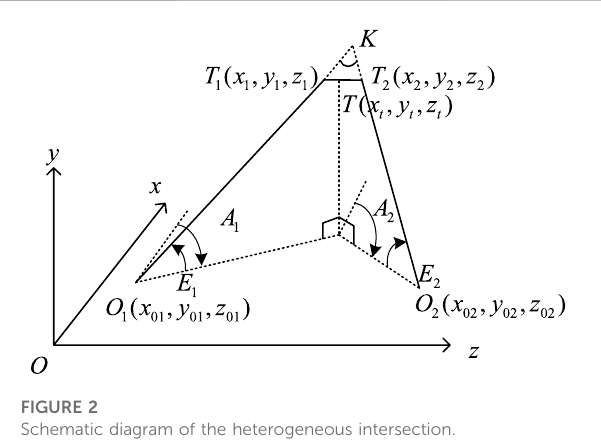
FIGURE 2 Schematic diagram of the heterogeneous